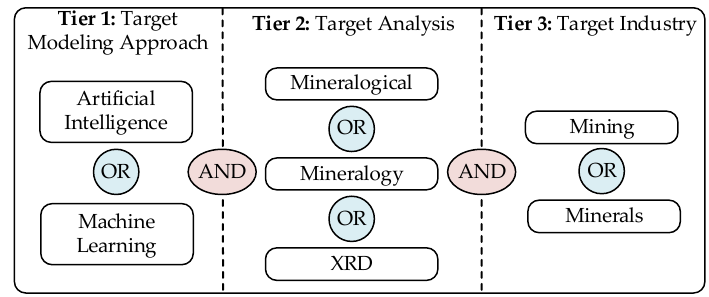
Figure 1. Search keywords and search query logic.